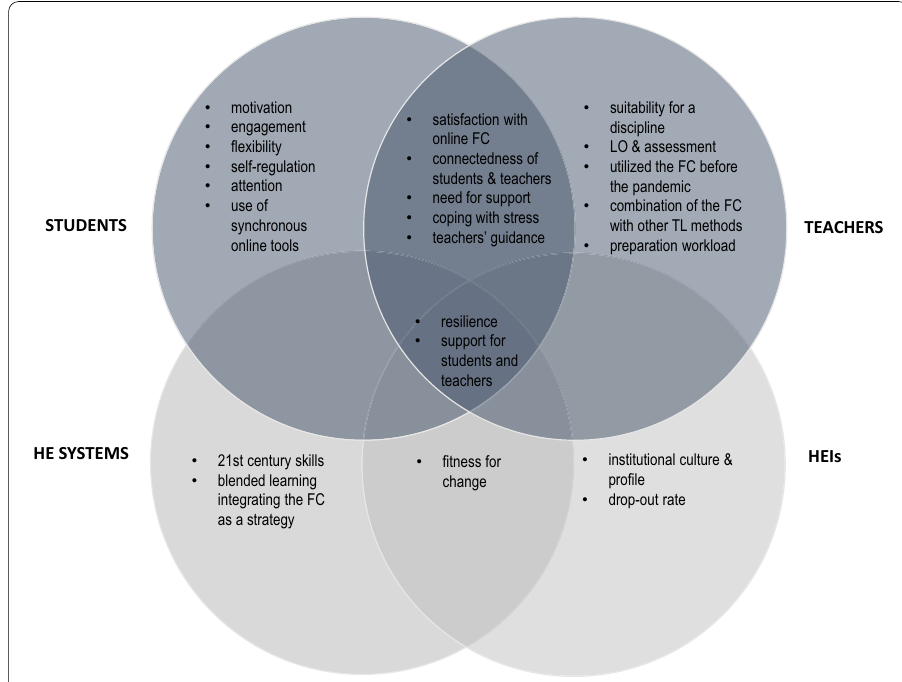
Fig. 3 An overview of the major topics explored by the